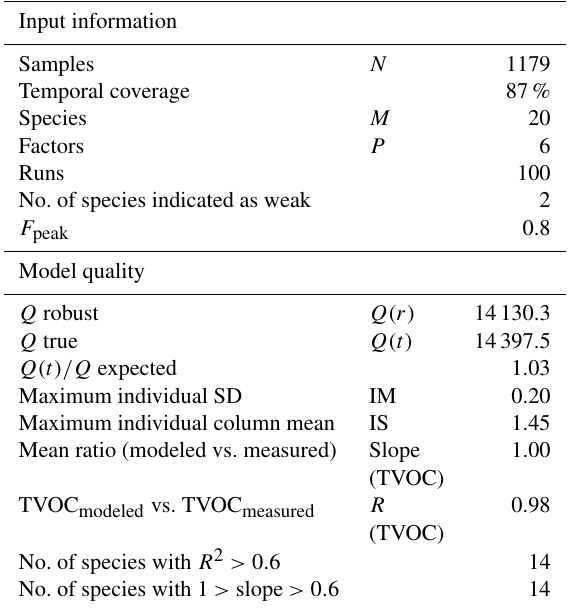
Table 2. Input information and mathematical diagnostic for the re- sults of PMF